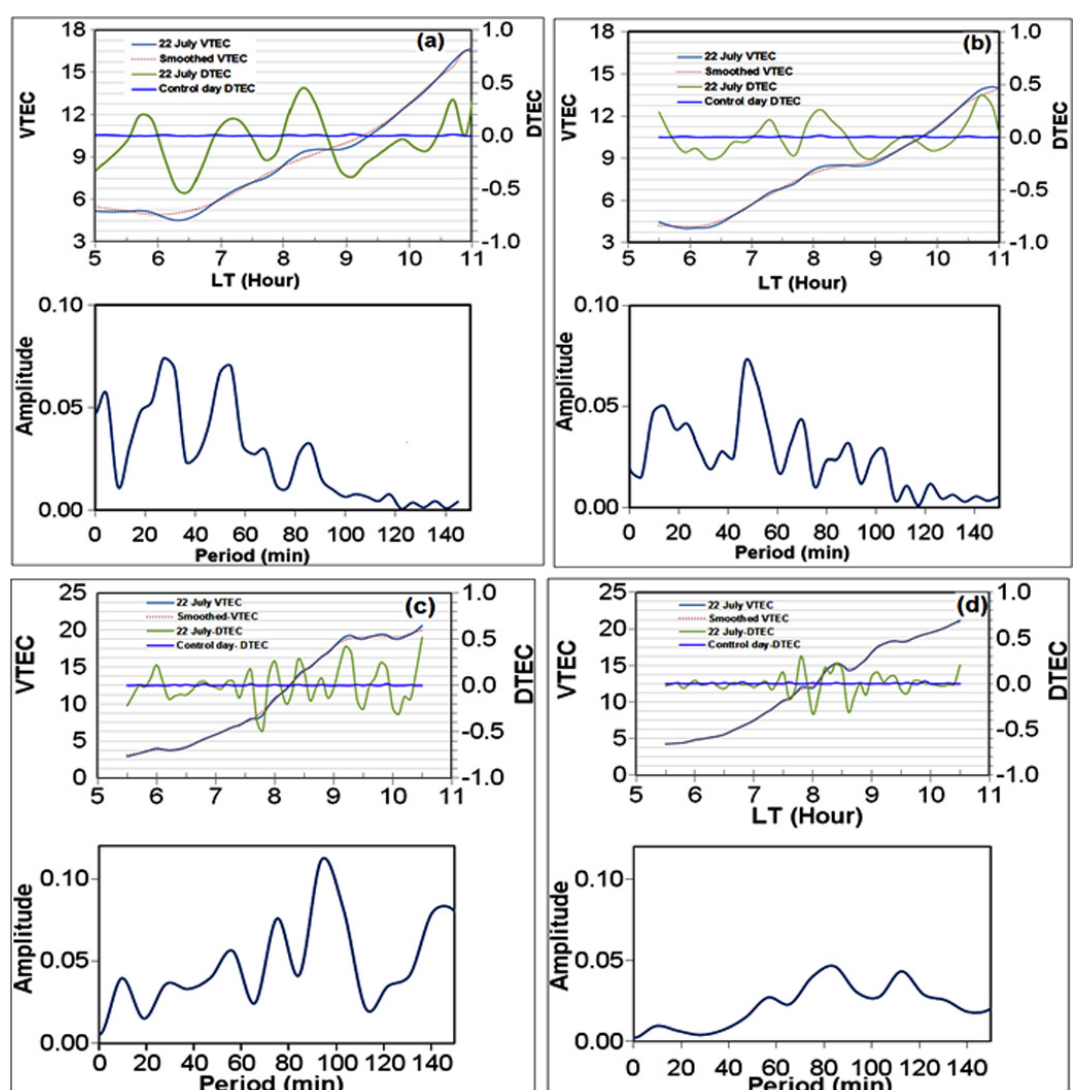
Fig. 4. Variation of VTEC, smoothed TEC (best polynomial fit to VTEC curve) and DTEC curve obtained by subtracting best polynomial fit to the original VTEC. Bottom panel shows the Fourier analysis of DTEC. (a) Varanasi, (b) Kanpur, (c) Hyderabad and (d)